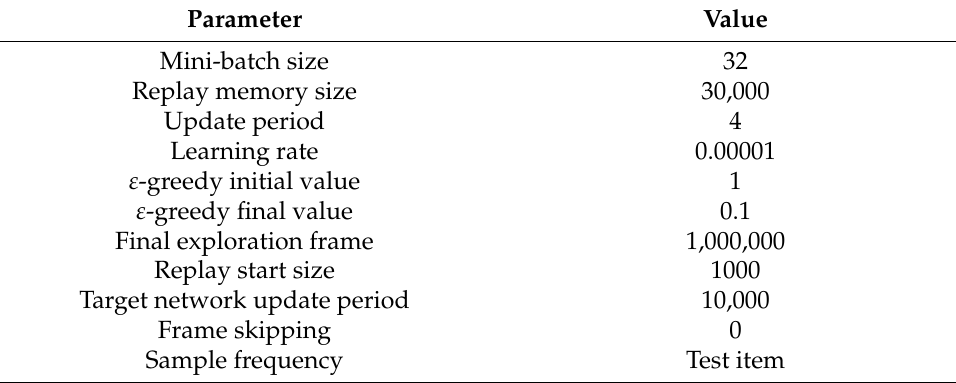
Table 7. The parameters for testing sample